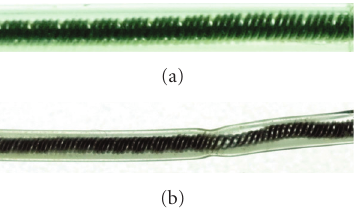
Figure 5: (a) Normal Lead. (b) We observed an explanted lead di ff erent from Figure